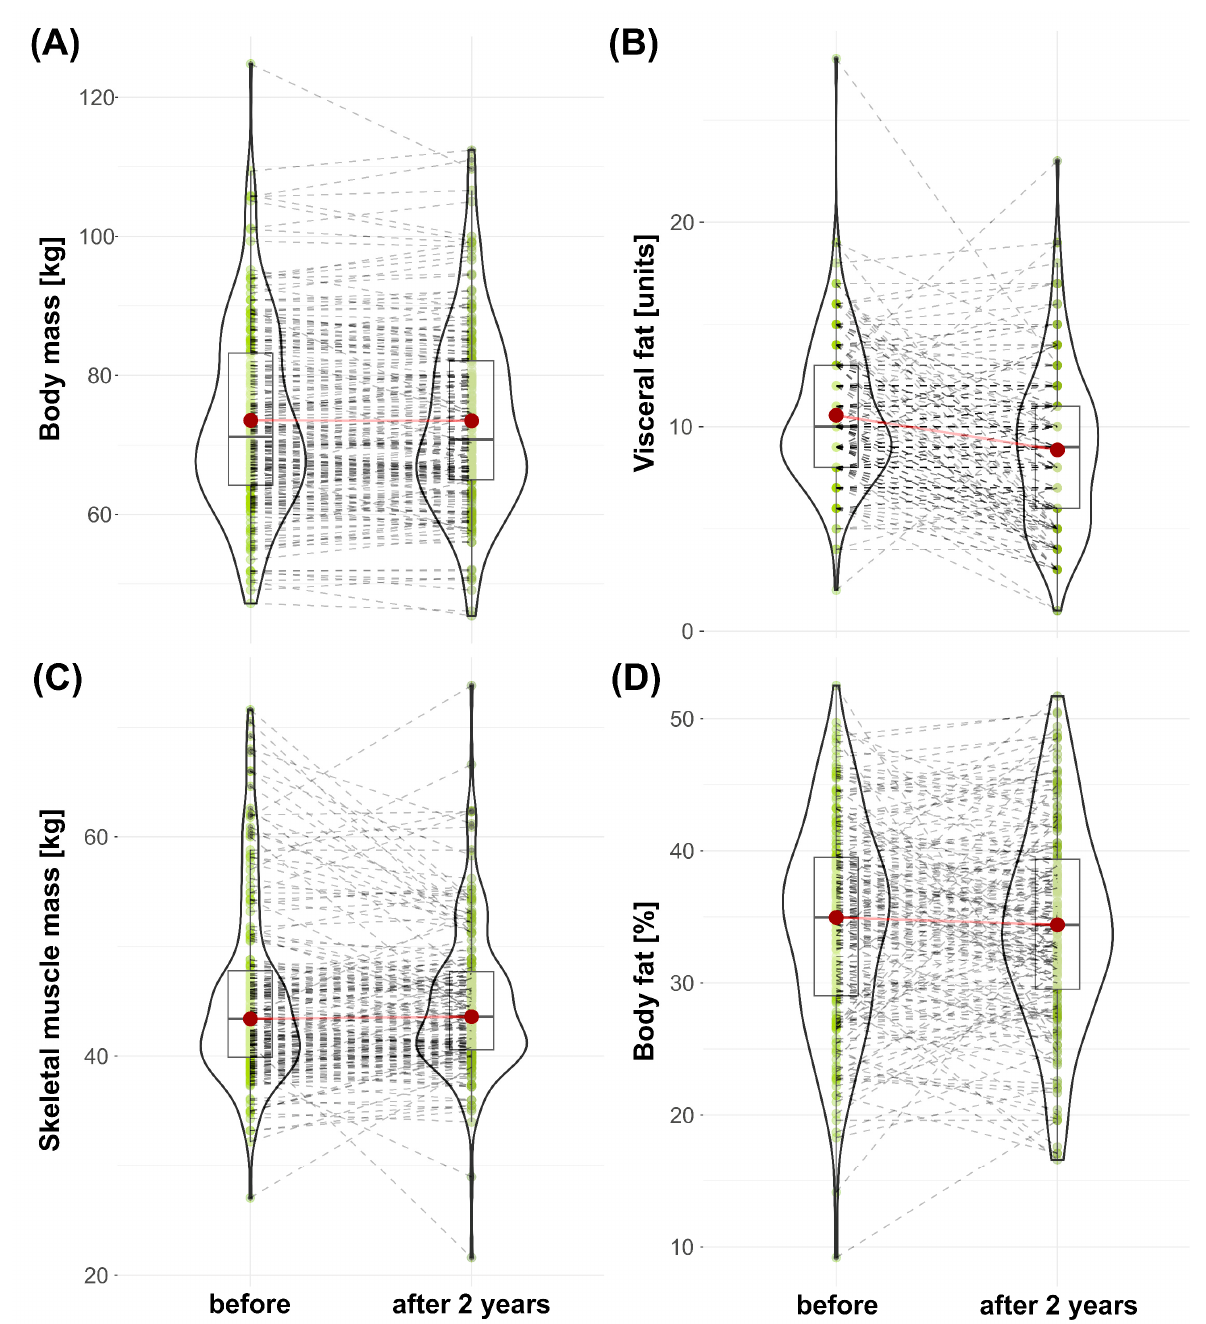
Figure 1. Changes in body mass and composition within two years: ( A ) change in body mass (kg) vs. after 2 years, ( B ) change in visceral fat (units) vs. after 2 years, ( C ) change in muscle mass (kg) vs. after 2 years, ( D ) change in body fat (%) vs. after 2 years. The shape of the violin graph corresponds to the distribution of values. The median value is illustrated by the horizontal black line inside the box, and the green dots connected by dashed grey lines show the results of individual participants. The arithmetical mean value is illustrated by the dark red dots connected by a light red line.